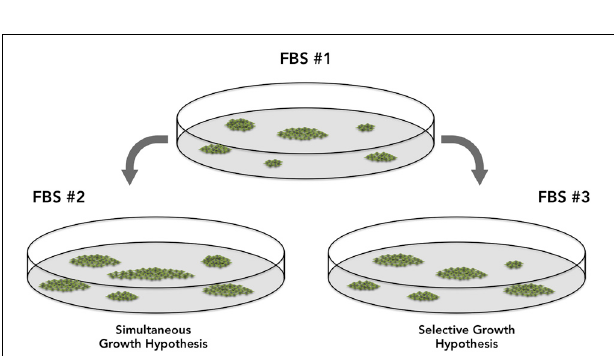
FIGURE 2 | Two hypotheses discussing the potential differences in the Colony Forming Efficiency results associated with the usage of different fetal bovine serum lots. The “Simultaneous Growth Hypothesis” suggests colonies are similarly affected and respond simultaneously, proliferating more or less, but in the same proportion. The “Selective Growth Hypothesis,” suggests that in response to different FBS lots, a few progenitors will proliferate more than others, as a result of growth factors concentration and